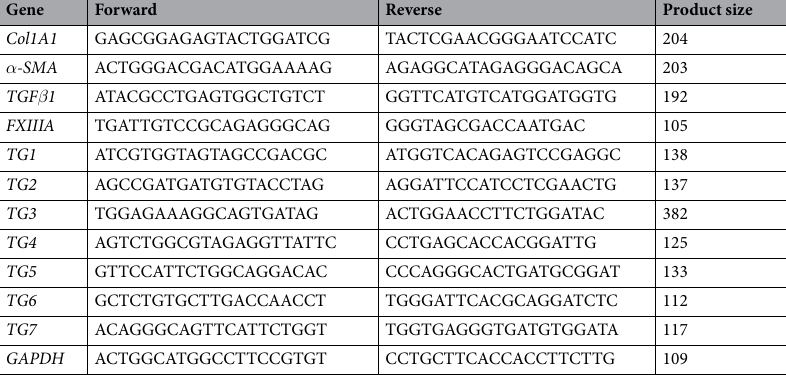
Table 3. Primer pairs for RT-PCR experiments using mouse renal